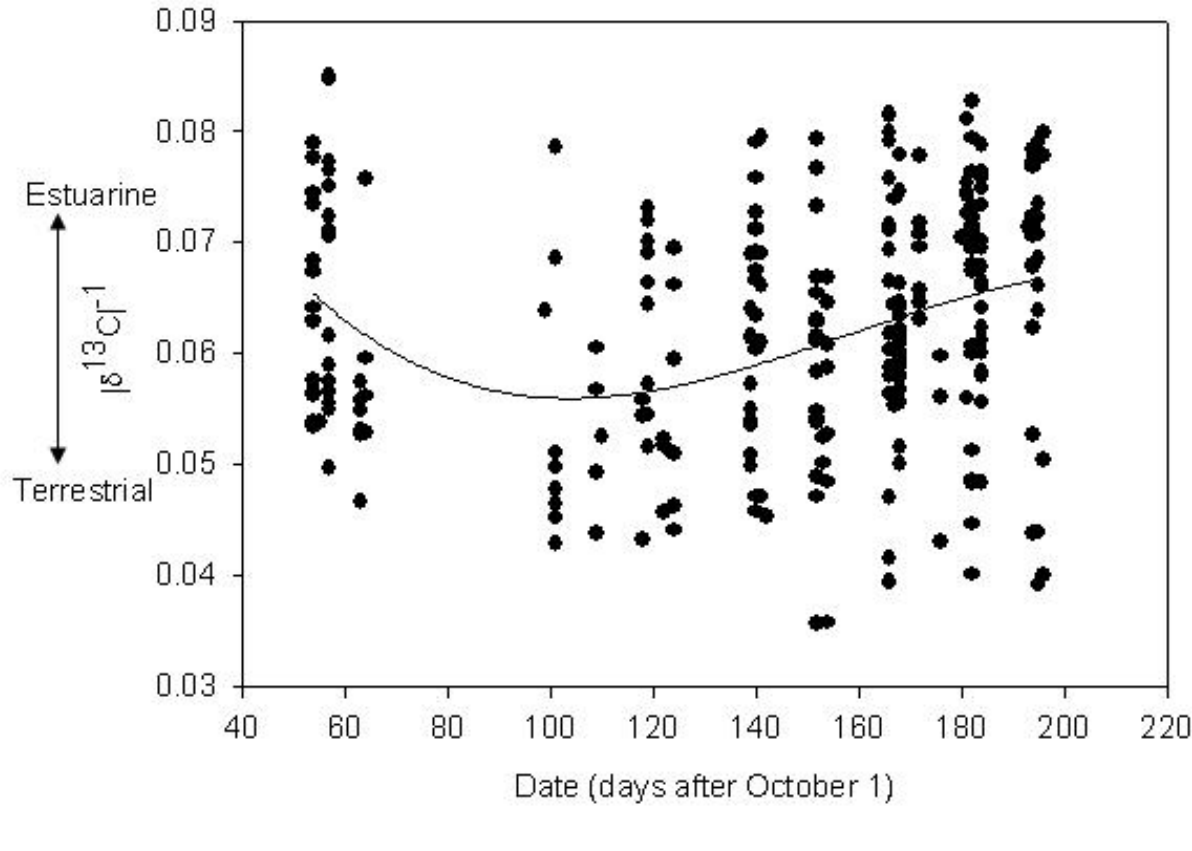
Fig. 3 . Cubic regression fit for date versus predicted relative contribution of terrestrial diet for all Dunlin sampled over four winters. The predictive equation is: y = 0.1070 - 0.0012x + 0.0000084x 2 + 0.000000018x 3 , r 2 = 0.091, P = < 0.0001. The Y-axis represents a transformation of d 13 C data (| d 13 C| -1 ) and is an index of relative use of each ecosystem (estuarine versus terrestrial) in Dunlin diet. [ See